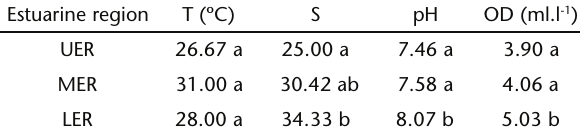
Table II. Results from the Tukey test for the water physicochemical parameters between the upper (UER), mid (MER), and lower (LER) estuary regions of the Rio Formoso (Pernambuco) (n = 18 for each estuary region). Different letters discriminate statistically homogeneous